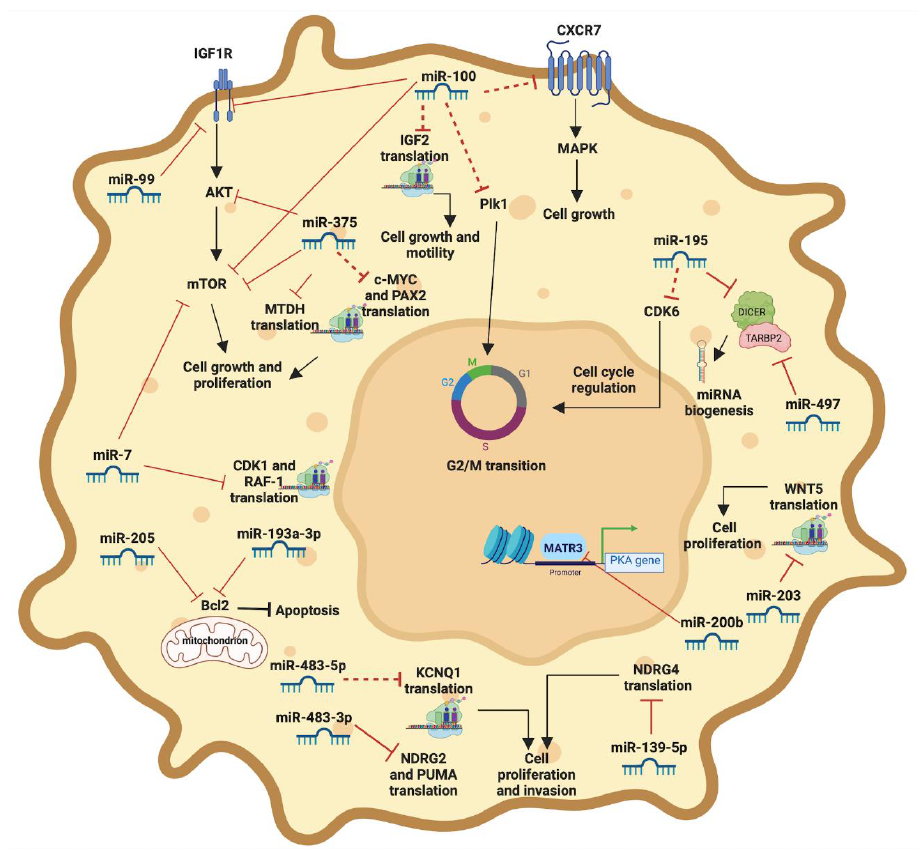
Figure 1. The image depicts the tumorigenesis pathways in which the principal miRNAs are involved in ACC pathogenesis. Dotted red lines represent the potential pathways regulated by miRNAs evaluated in other types of cancer. Continuous red lines represent the pathways regulated by miRNAs evaluated in ACC models. Image created with BioRender.com.